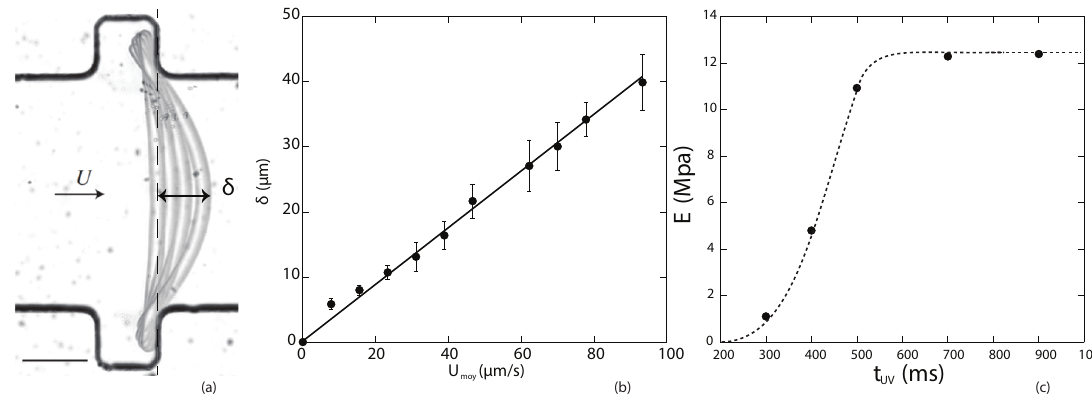
Figure 4. Adapted from [13] with permission from the Royal Society of Chemistry, 2015. ( a ) Successive positions of deformed fiber; ( b ) measured fiber deformation with respect to the flow velocity; ( c ) results of Young’s moduli for different exposure times. A movie showing the fiber deforming under flow is available in Supplementary Materials Video